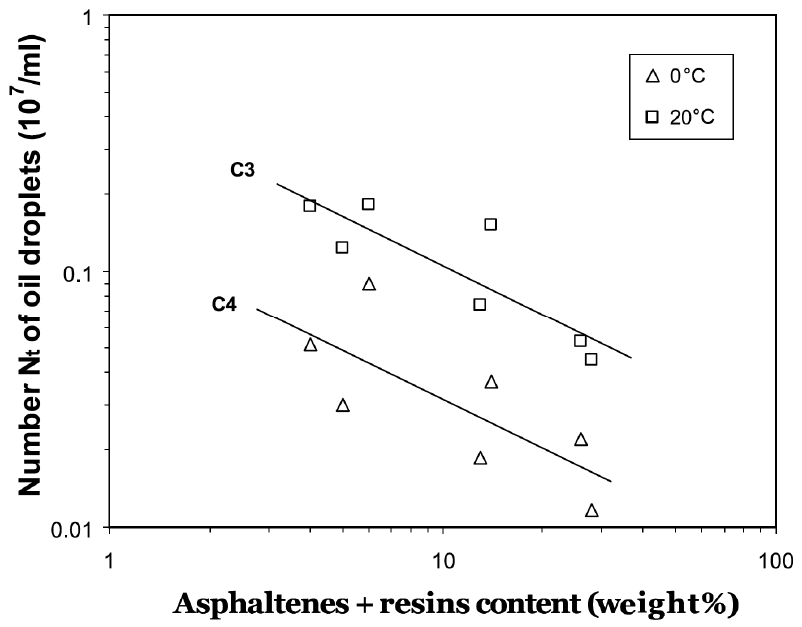
Figure 7. Variations of number concentration of OMA with asphaltenes + resins content (ARC) (extracted from Khelifa 2002) [67]. (Copyright 2002 Elsevier Ltd.).